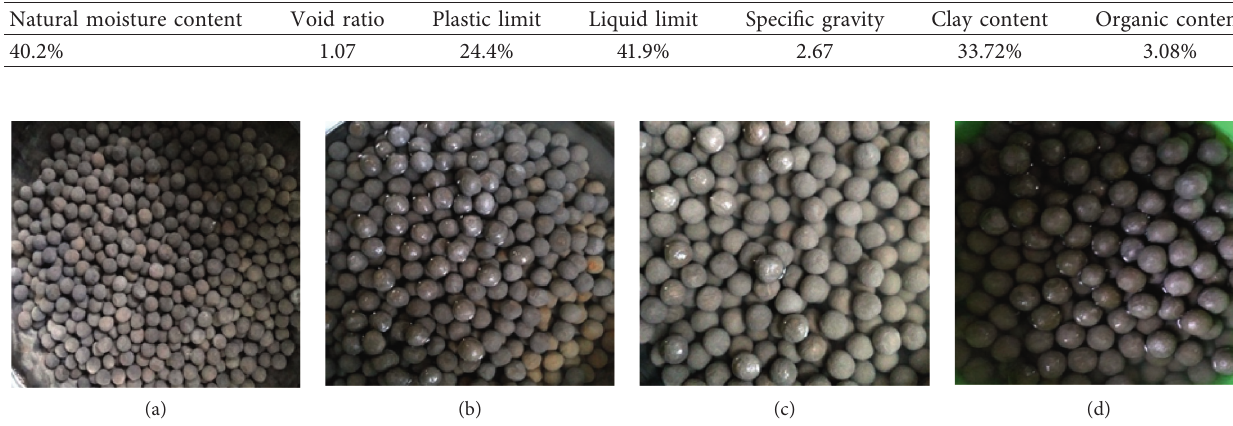
Table 1: Physical and mechanical properties of test